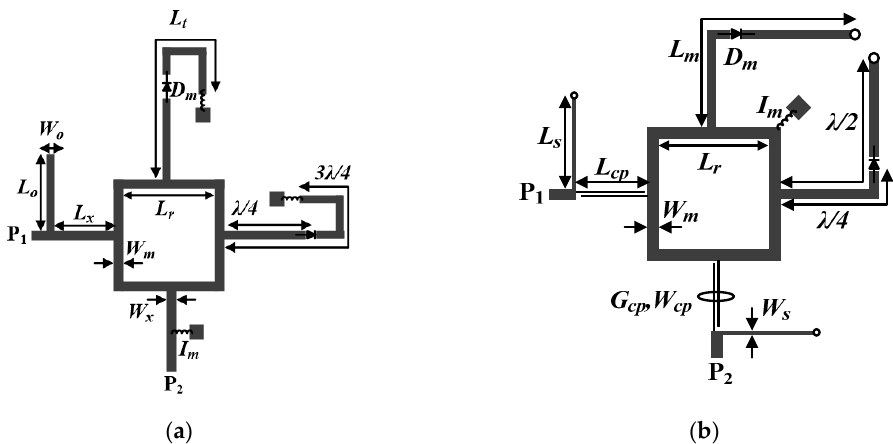
Table 2. Design dimensions for 3 λ g /4 open-ended stubs (Units: mm).